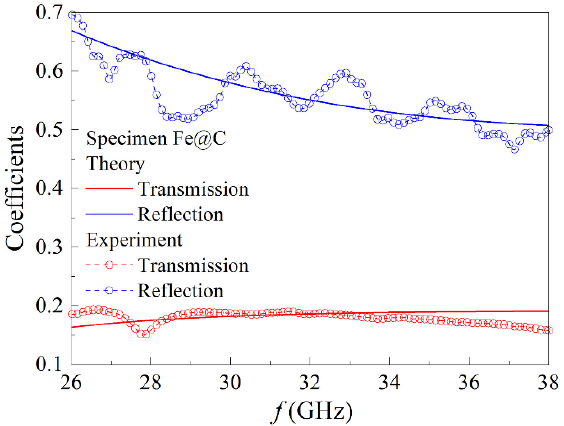
Figure 7. Frequency dependences of the transmission and reflection coefficients in the millimeter waveband and their approximations for the nanocomposite sample of 2 mm in thick with Fe@C particles.